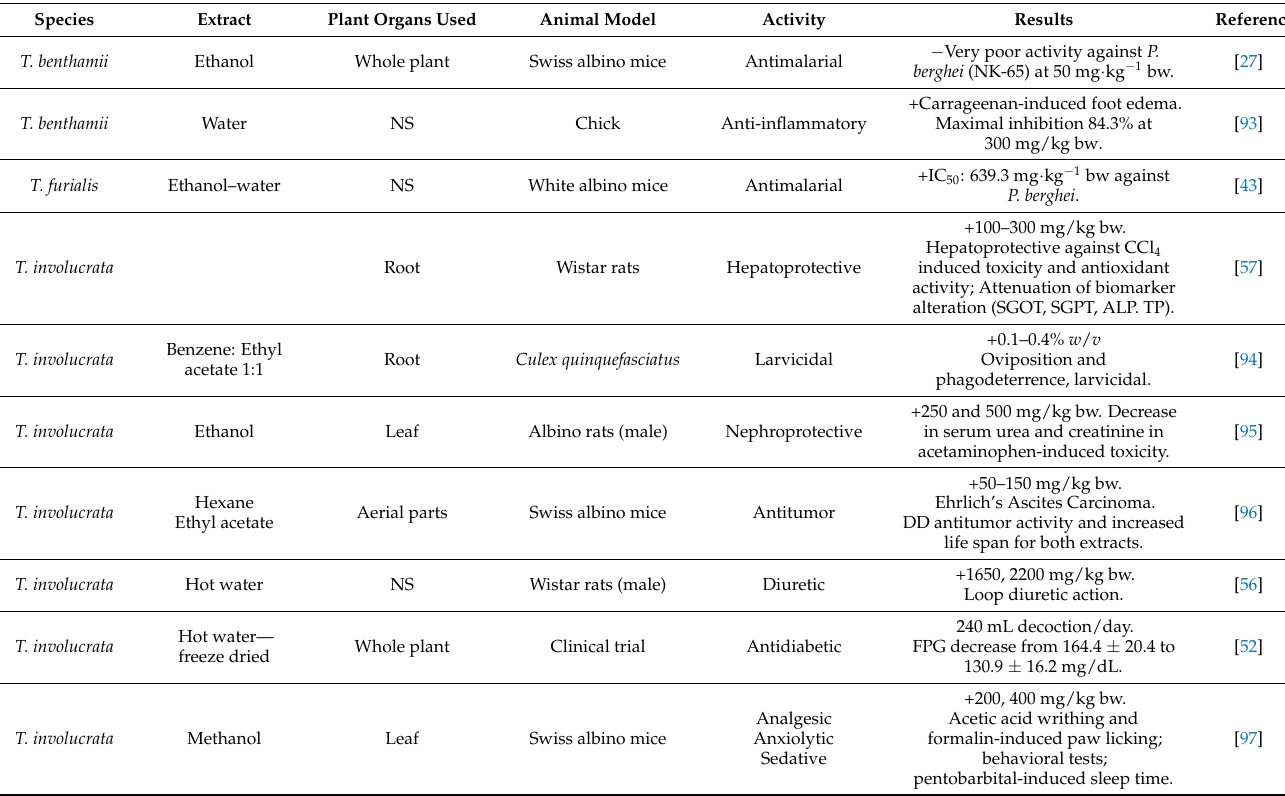
Table 3. In vivo activity of Tragia extracts.